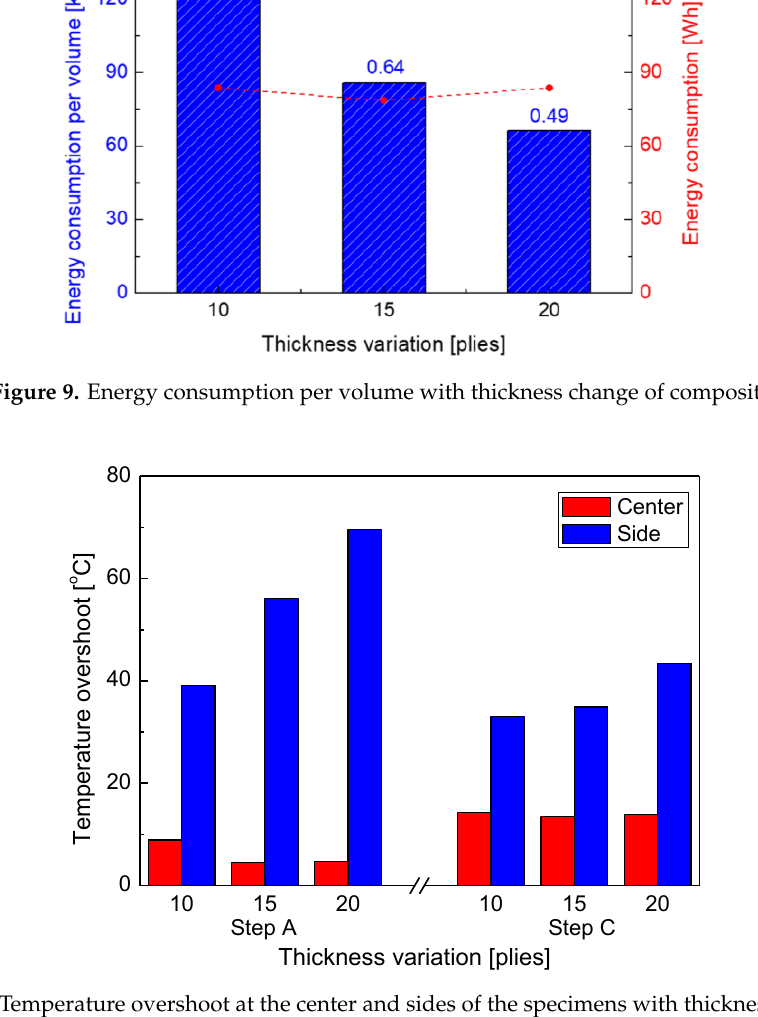
Figure 10. Temperature overshoot at the center and sides of the specimens with thickness variation.